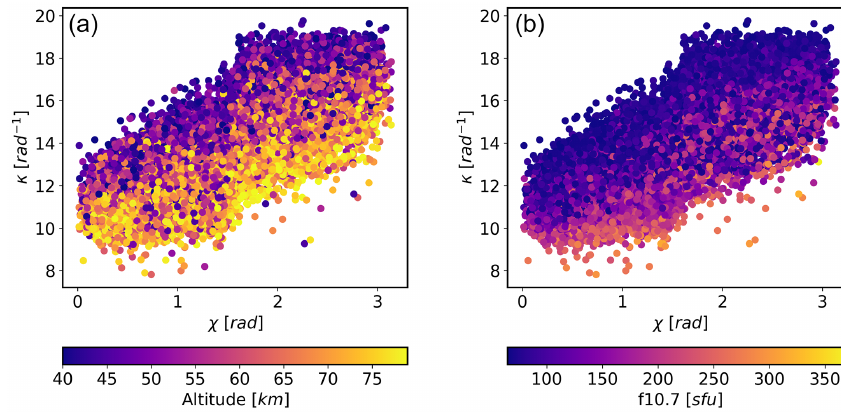
Figure 11. κ vs. solar zenith angle ( χ ), colour coded by altitude (a) and F10.7 (b) . 1sfu = 10 − 22 Wm − 2 Hz − 1 .